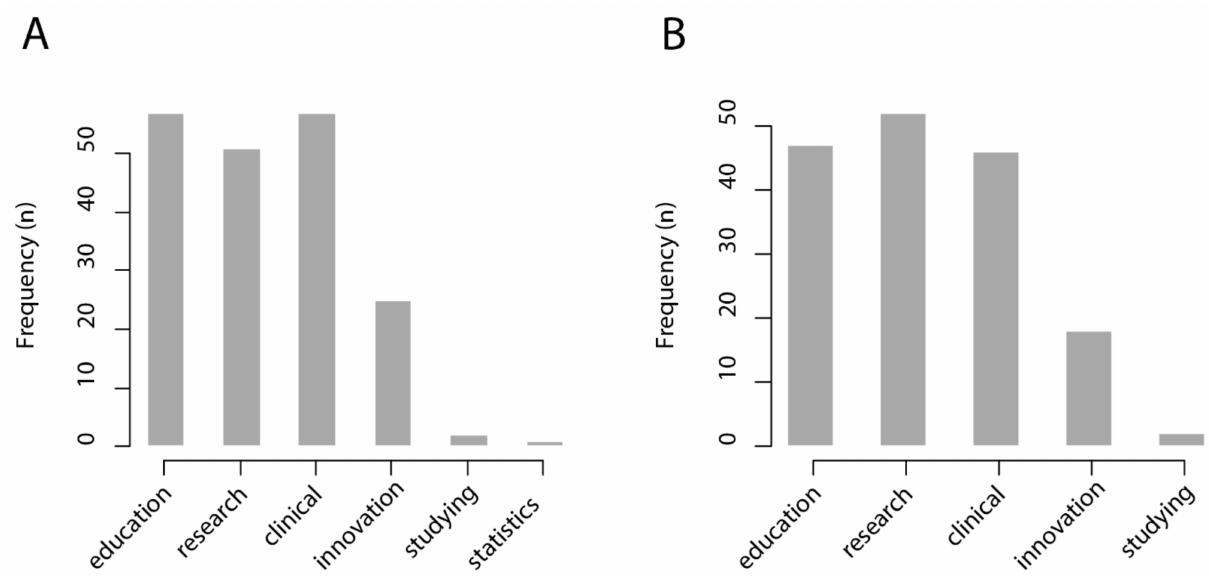
Figure 4. Results of the survey among professionals of the healthcare sector ( n = 67). Medical education, research, and clinical care were considered the most relevant use cases for ( A ) a content-based medical image retrieval system and ( B ) an intelligent interactive visual